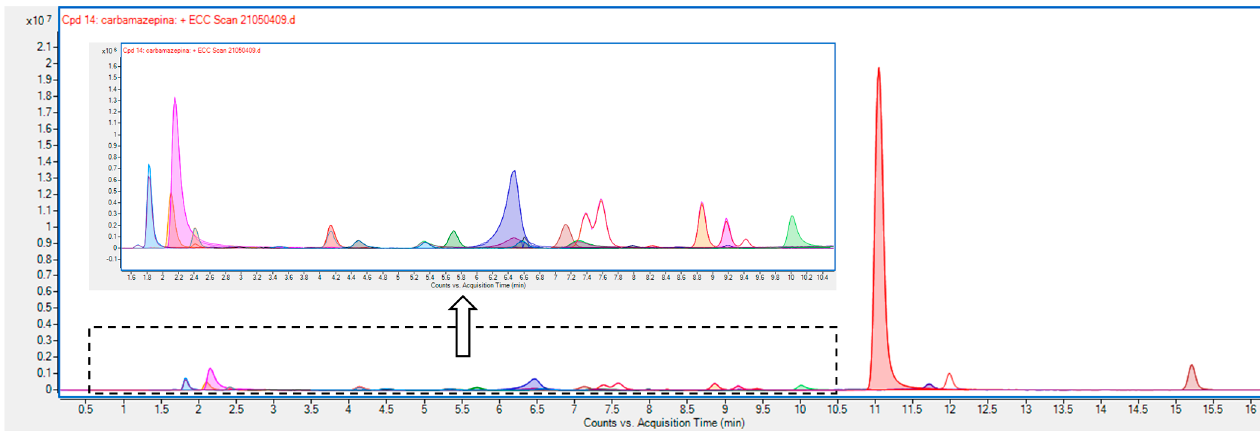
Figure 9. Chromatographic profile of the major compounds detected in the sample of carbamazepine oxidized to pH = 3.0. Experimental conditions: (CBZ) = 50.0 mg/L; (Fe) = 10 mg/L; (H 2 O 2 ) = 15.0 mM; T = 25 °C; (UV) = 150 W.